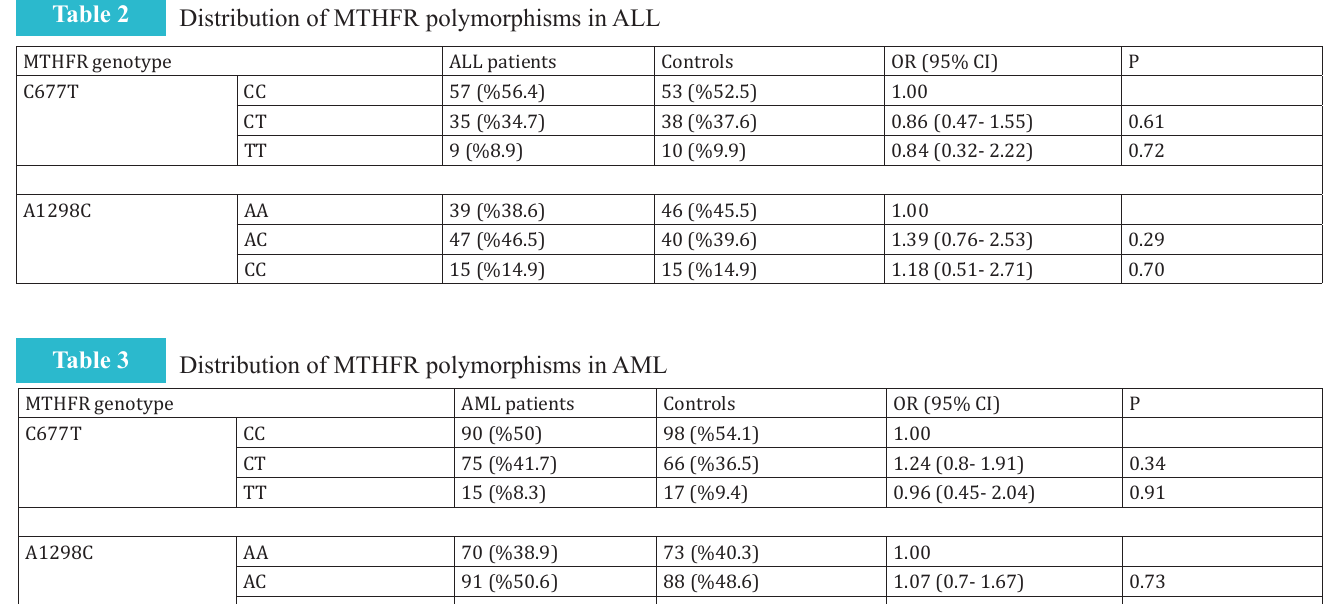
Distribution of MTHFR polymorphisms in ALL